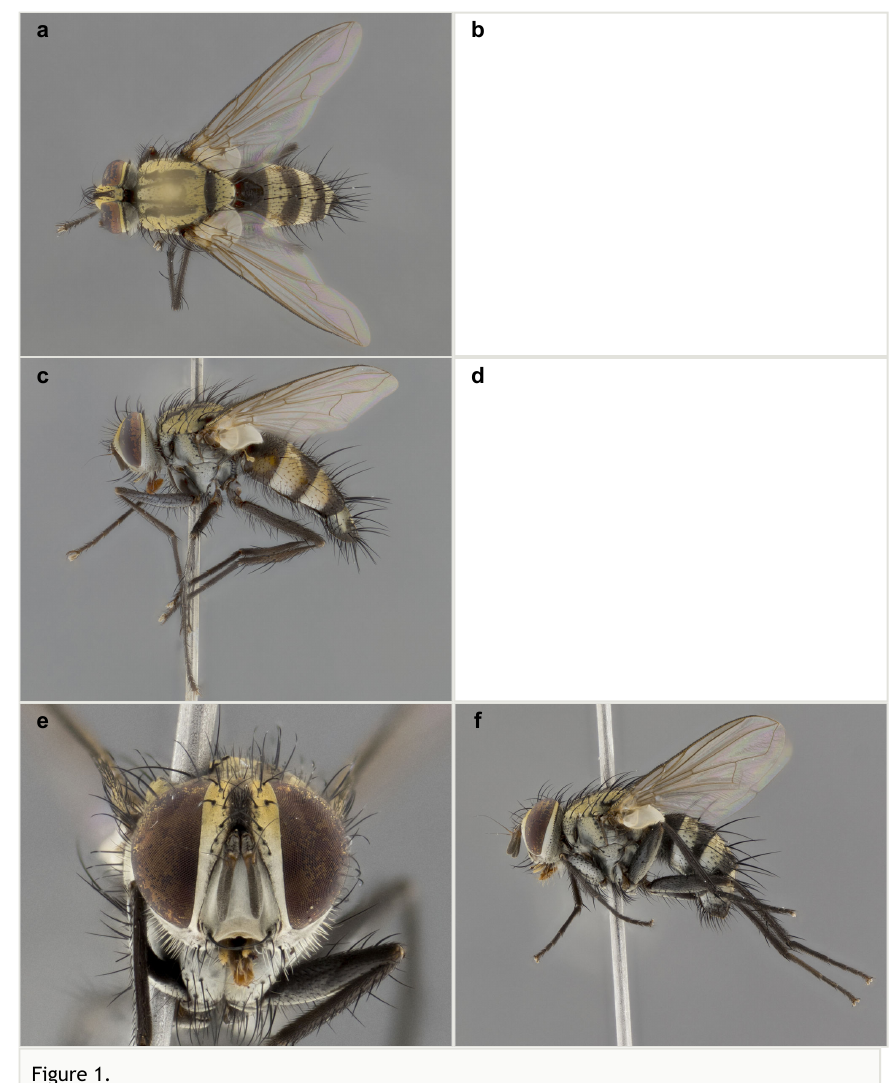
General morphology of Calolydella adelinamoralesae sp. n. ; a–c : male holotype, voucher